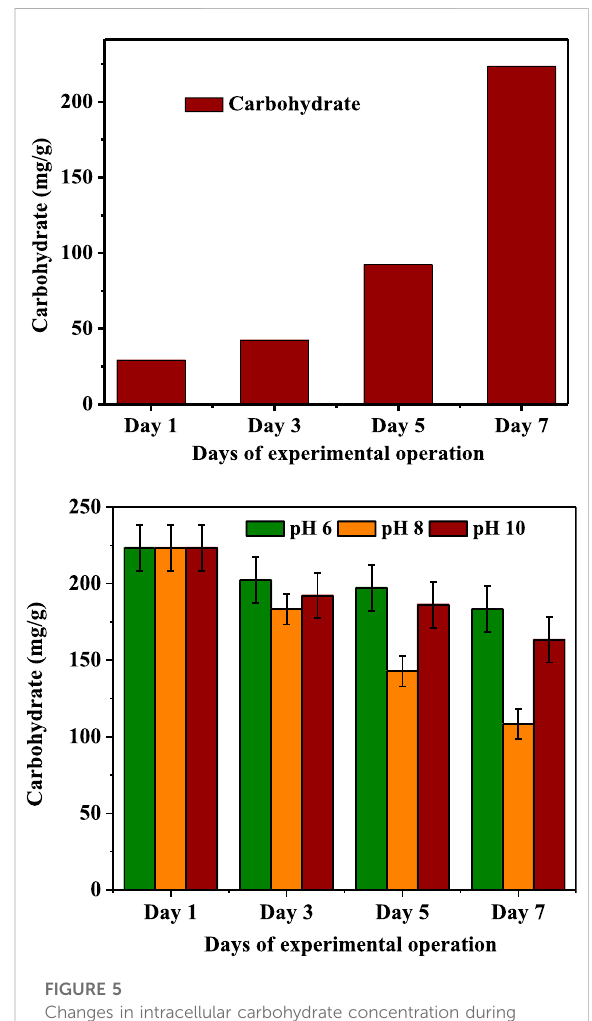
FIGURE 5 Changes in intracellular carbohydrate concentration during the growth phase and pH-induced stress